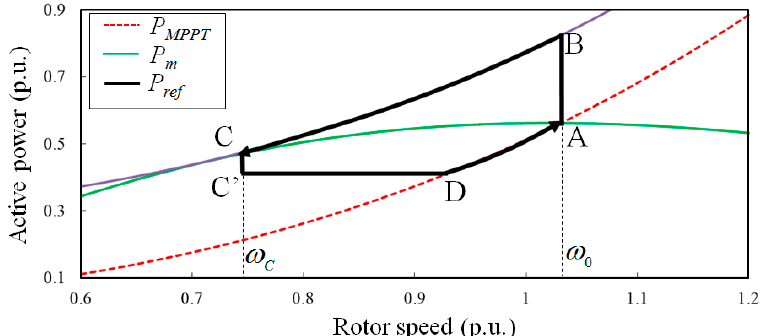
Figure 3. Power-rotor speed trajectory of the conventional short-term frequency support (STFS) method.